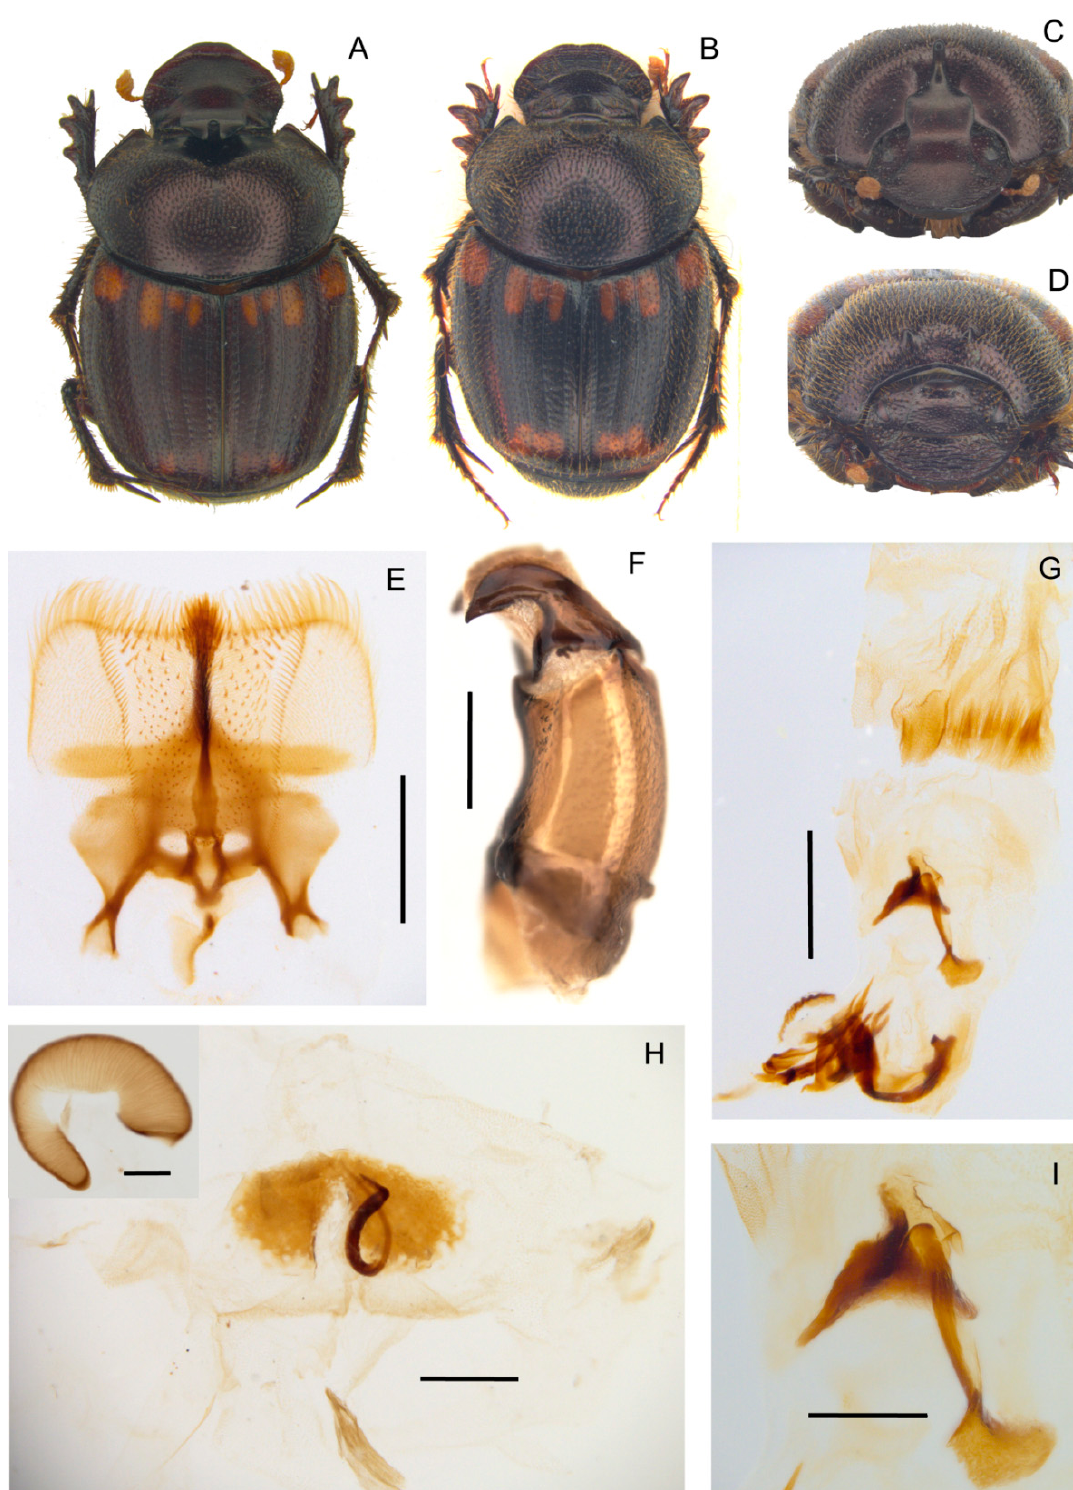
Figure 13. Features of Tiaronthophagus zambesianus n.sp. ( A ): Male facies (above). ( B ): Female facies (above). ( C ): Male facies (frontal view). ( D ): Female facies (frontal view). ( E ): Epipharynx, scalebar = 0.4 mm. ( F ): Male genitalia, phallobase and parameres, scalebar = 0.5 mm. ( G ): Male genitalia, endophallus, scalebar = 0.5 mm. ( H ): Female genitalia, vagina, scalebar = 0.3 mm, and receptaculum seminis, scalebar = 0.1 mm. ( I ): Male genitalia, lamella copulatrix, scalebar = 0.2 mm.